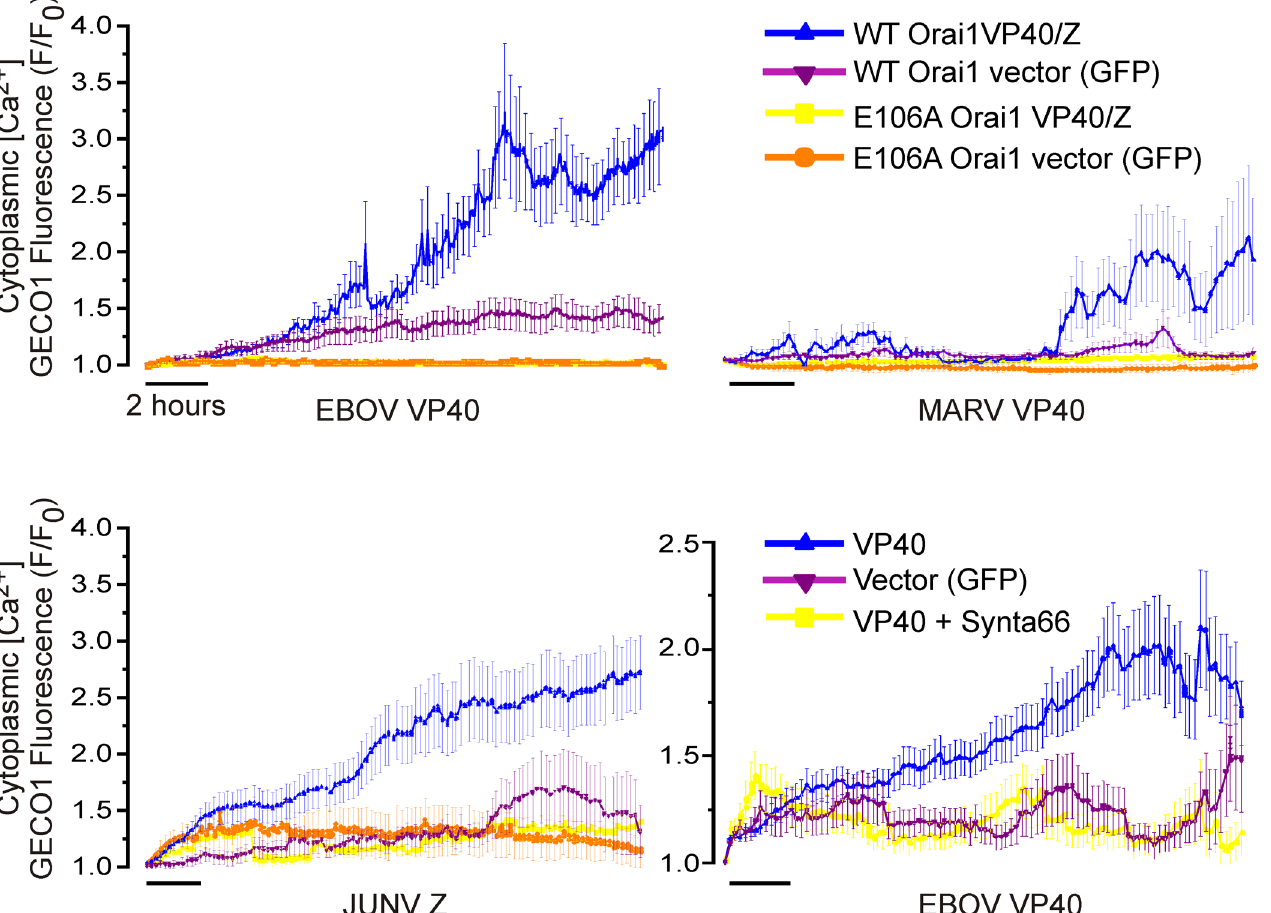
Fig 1. Viral matrix protein expression mobilizes cytoplasmic Ca 2+ . Viral matrix proteins or vector controls and the genetically encoded Ca 2+ indicator R-GECO-1 were co-expressed in WT HEK293T cells, HEK293T cells stably expressing the dominant negative permeation defective Orai (E106A) mutant, or WT HEK293T cells treated with the Orai inhibitor Synta66 (50 μ M, lower right). Cytoplasmic R-GECO-1 fluorescence emission (580nM) was monitored between 6 and 24 hours post transfection from cells cultured in an environmentally controlled chamber on the microscope stage. Each trace represents the average +/- SEM of at least two experiments of at least 20